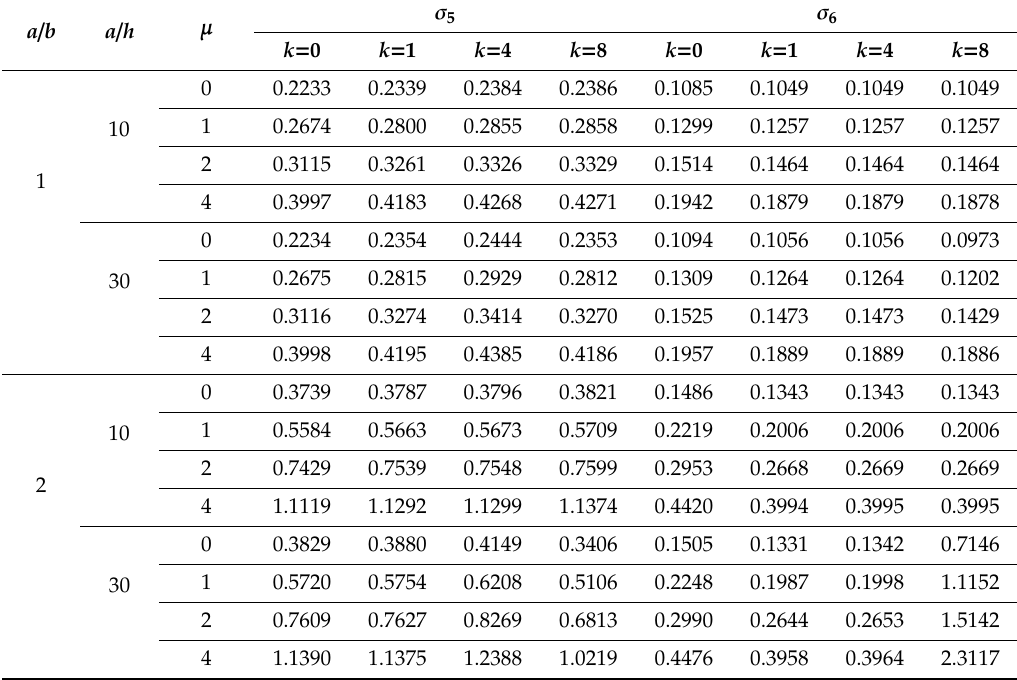
Table 5. The non-dimensional transverse stresses in FG nano-scale